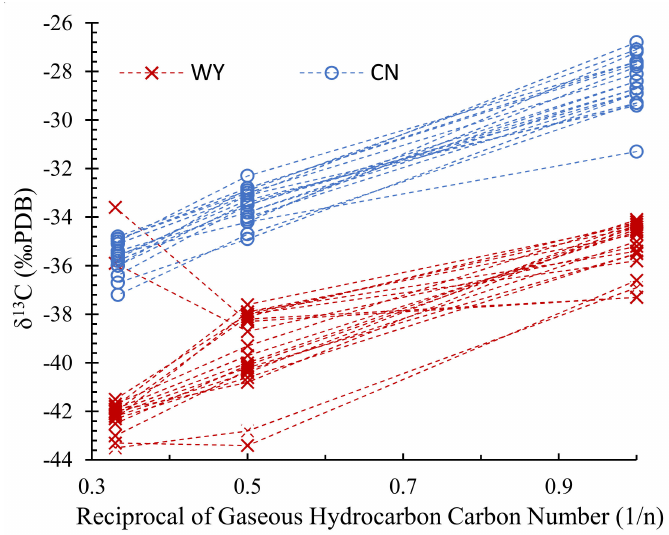
Figure 4. Carbon isotopic composition of shale gas from the Longmaxi Formation in the Weiyuan and Changning areas, Sichuan Basin, China.